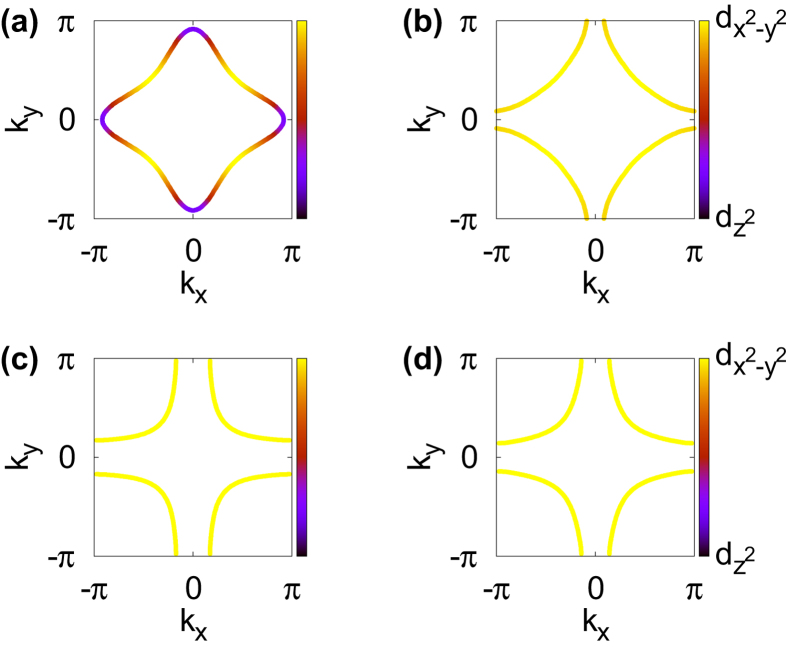
The orbital-resolved Fermi surfaces (kz = 0 plane) at the reduced eg band filling by 0.15 (hole doping):(a) La2CuO4 (LDA), (b) La2CuO4 (QSGW), (c) HgBa2CuO4 (LDA), and (d) HgBa2CuO4 (QSGW). The color represents the amount of  and  character.